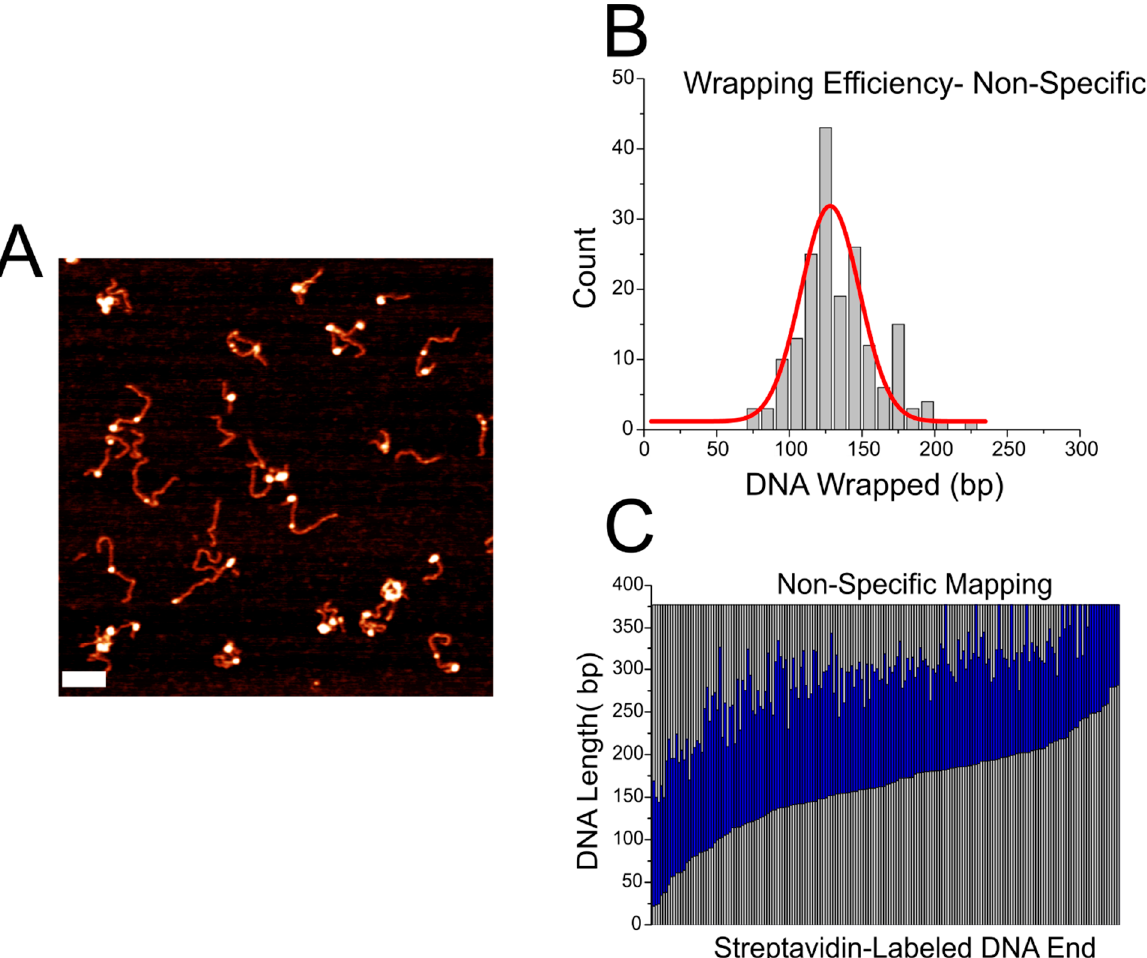
Figure 6. Analysis of CENP-A nucleosomes assembled on the non-specific DNA substrate. ( A ) Representative image of nucleosome samples. Scale bar indicates 100 nm. ( B ) Histogram of wrapping efficiency displays a broad Gaussian fitting with a peak centered around 128 ± 40 bp. ( C ) Mapping of nucleosomes assembled on non-specific DNA display no preferential